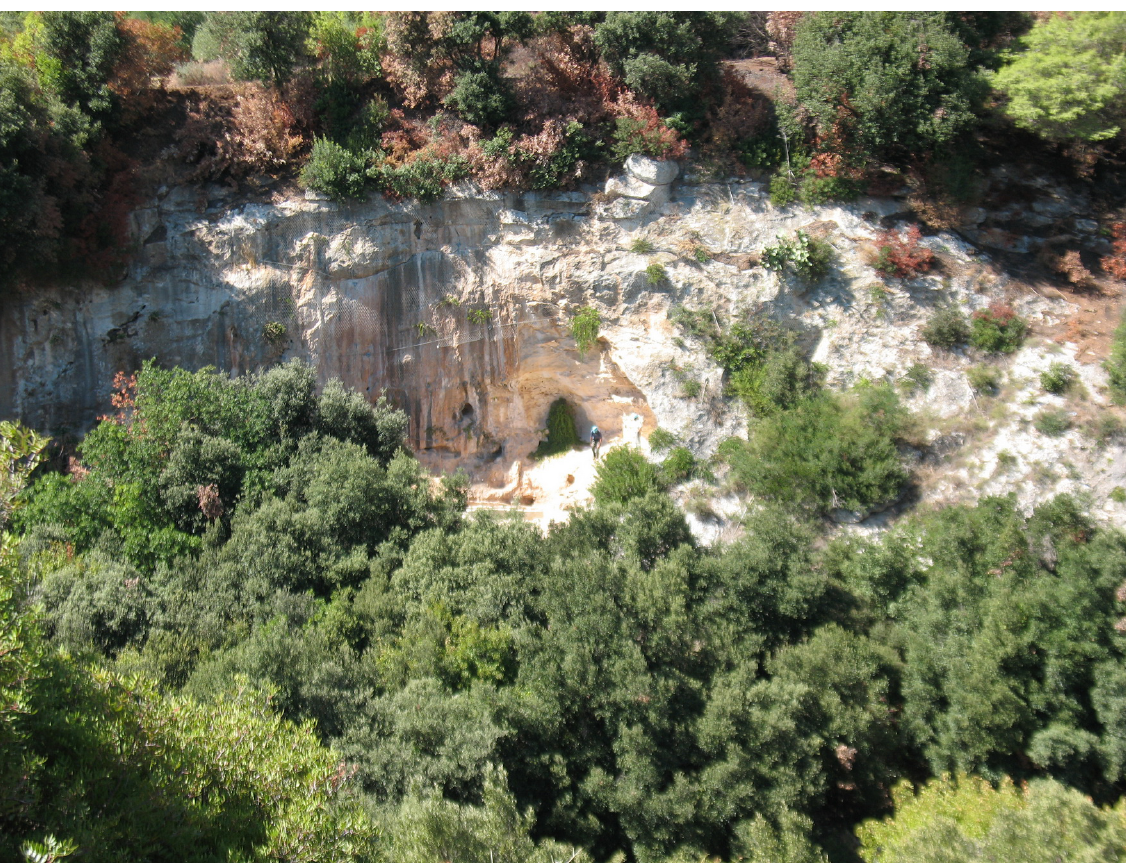
Figure 1.The Oscurusciuto rockshelter in the northern side of the ravine of Ginosa. (Photo by P.